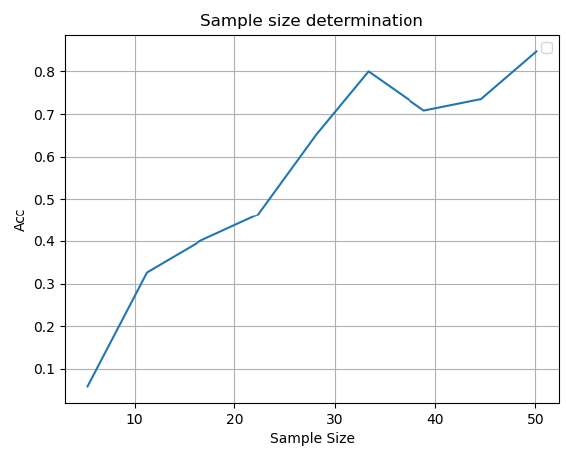
Figure 11. Sample size determination.